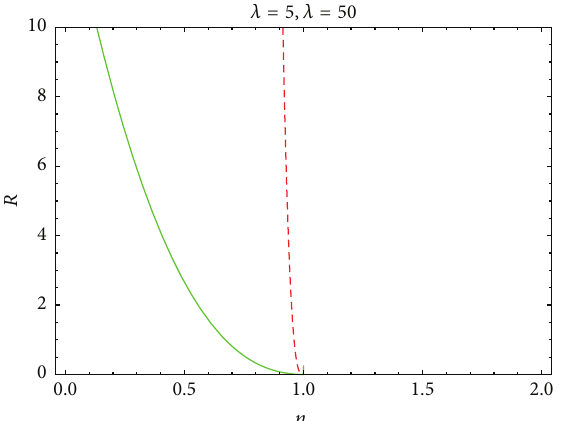
Figure 9: Tensor-scalar ratio in terms of spectral index 𝑛 𝑠 , ] = 50 by dashed line and ] = 5 by green line.